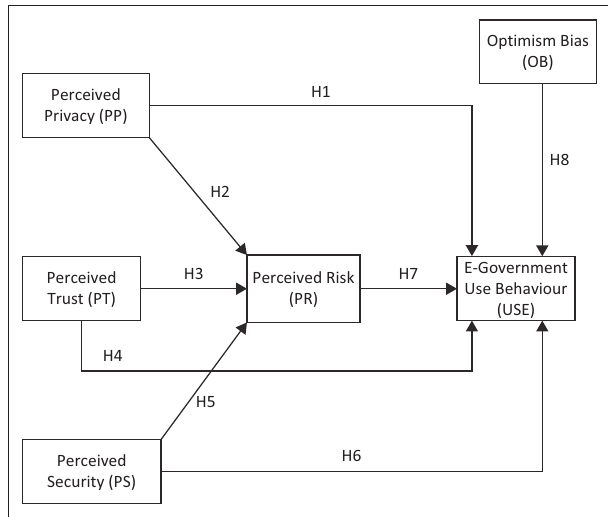
FIGURE 1: E-government use research